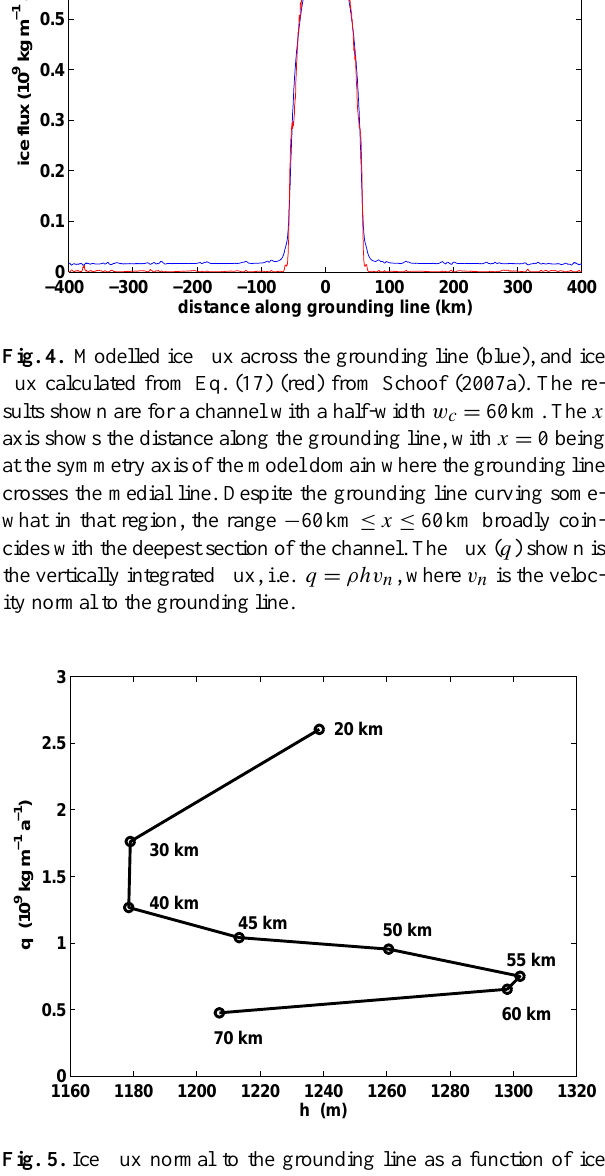
Fig. 5. Ice flux normal to the grounding line as a function of ice thickness. Each data point is calculated for a different model setup with half-widths values, ( w c , see Eqs. 22 to 24) ranging from 20 to 70km. In each case the flux values are from the locations where the grounding lines of the respective models cross the medial line ( y = 0).